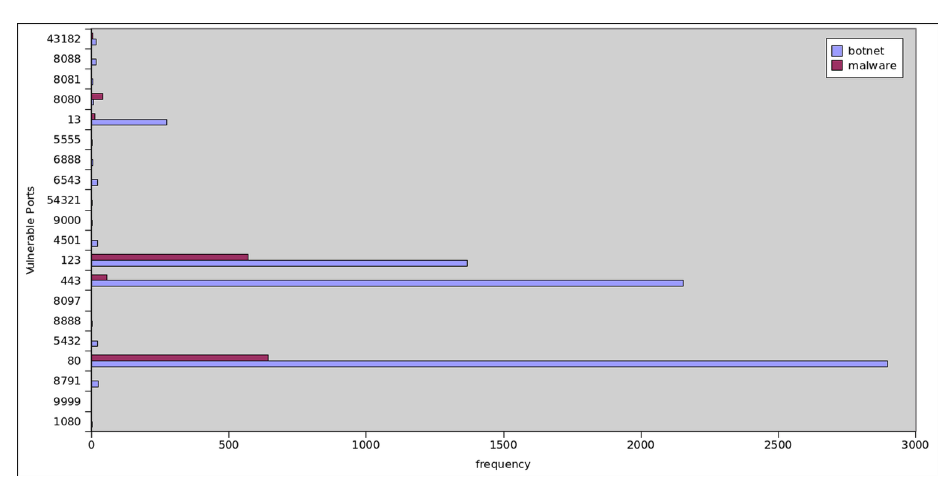
Fig 25. Vulnerable Ports Analysis between botnet and malware